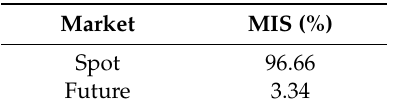
Table 6. Matrix Information Share